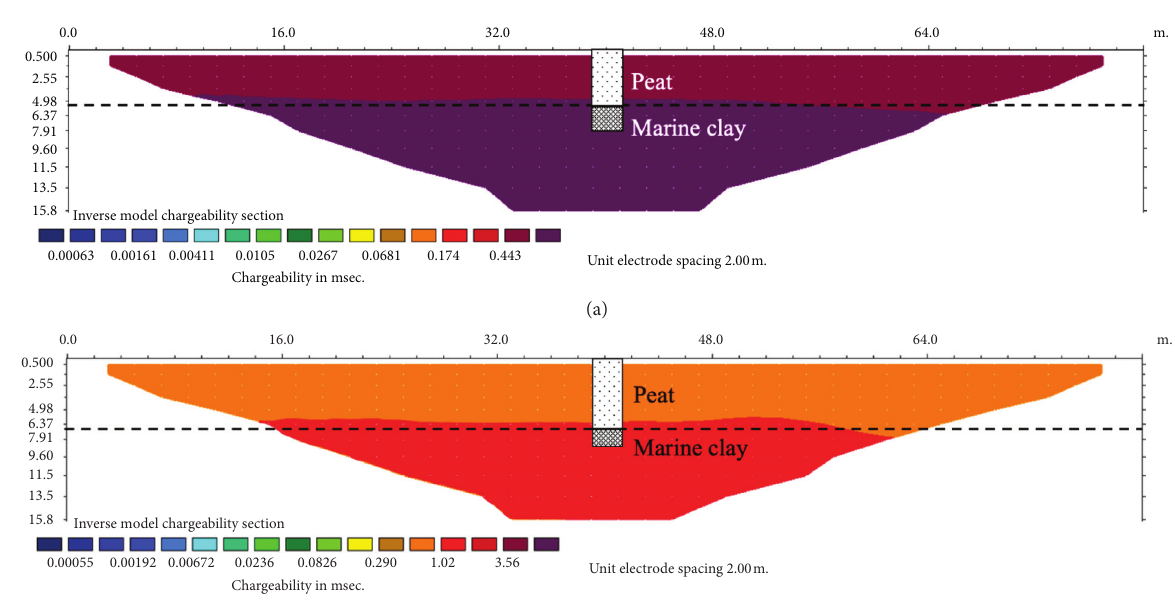
Figure 7: 2D chargeability images; (a) S2 and (b)